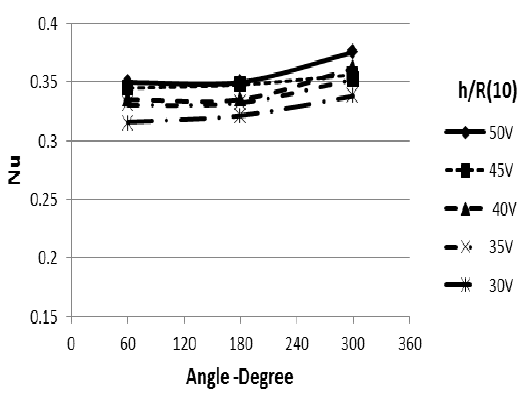
Figure 9. Local Nu with different voltages at a depth/radius ratio of 10.